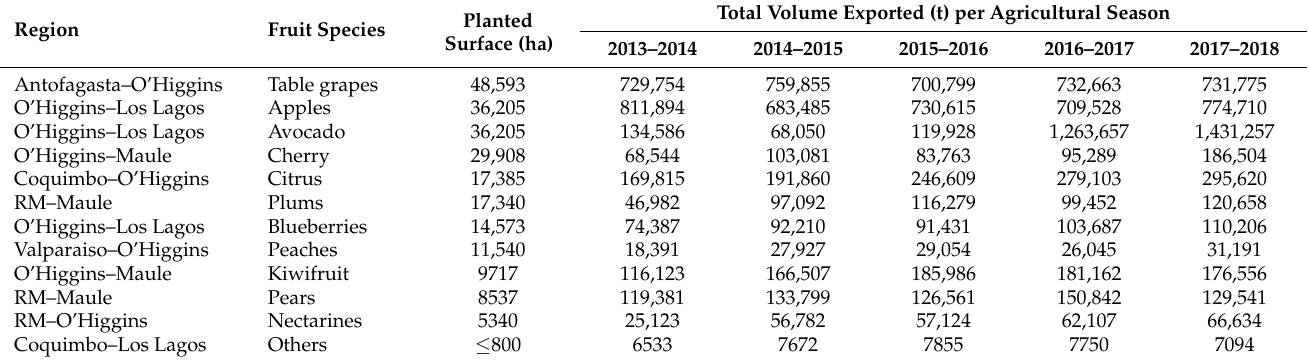
Table 2. Ranking of the main fresh fruits produced and exported by Chile between the years 2013 and